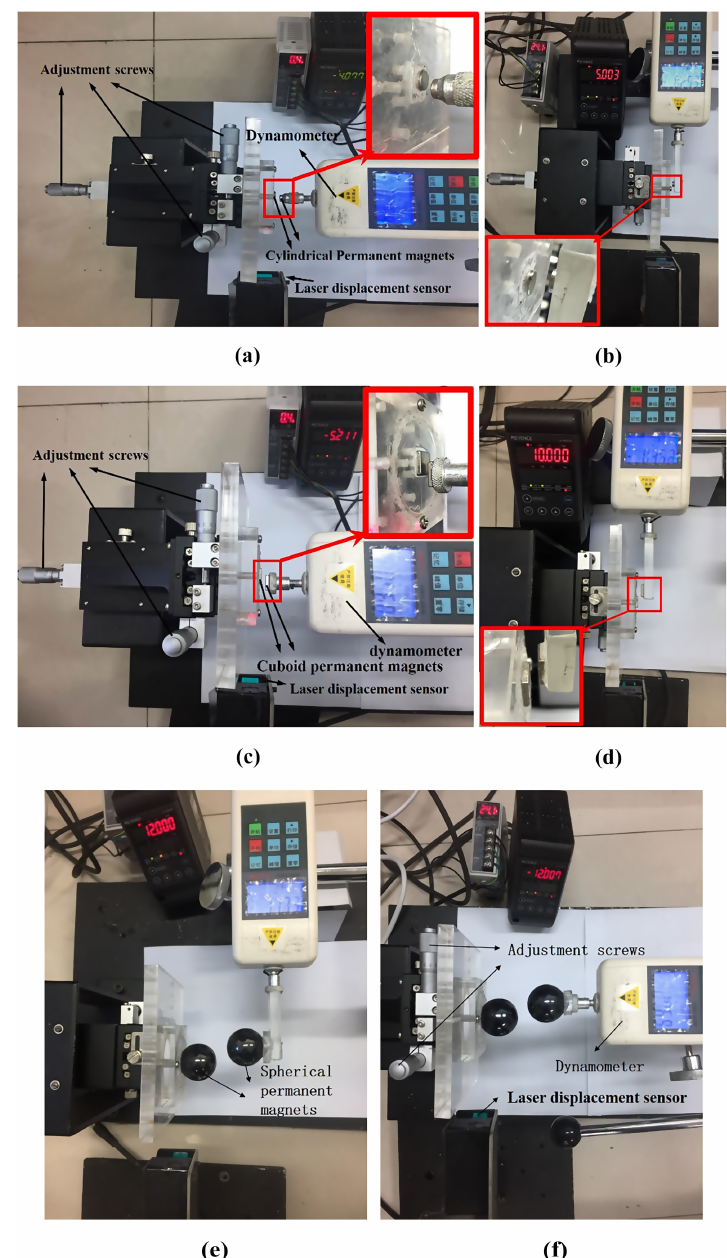
Figure 15. Magnetic force measurement system. (a) axial force between cylindrical magnet pair, (b) lateral force between cylindrical magnet pair, (c) axial force between cuboid magnet pair, (d) lateral force between cuboid magnet pair, (e) lateral forcebetweenspherical magnet pair, (f) axial forcebetweenspherical magnet